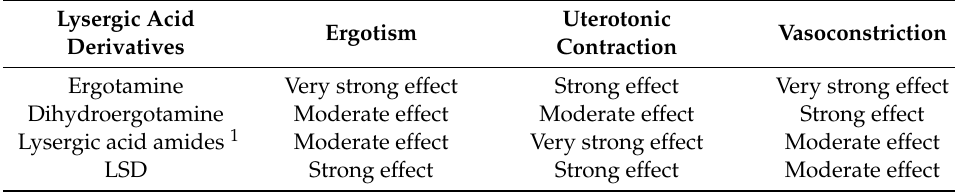
Table 1. Activity profile of ergot alkaloids — lysergic acid derivatives.